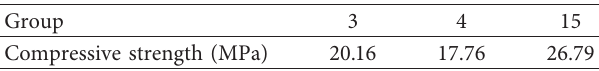
Table 8: Test results of grout unconfined compressive